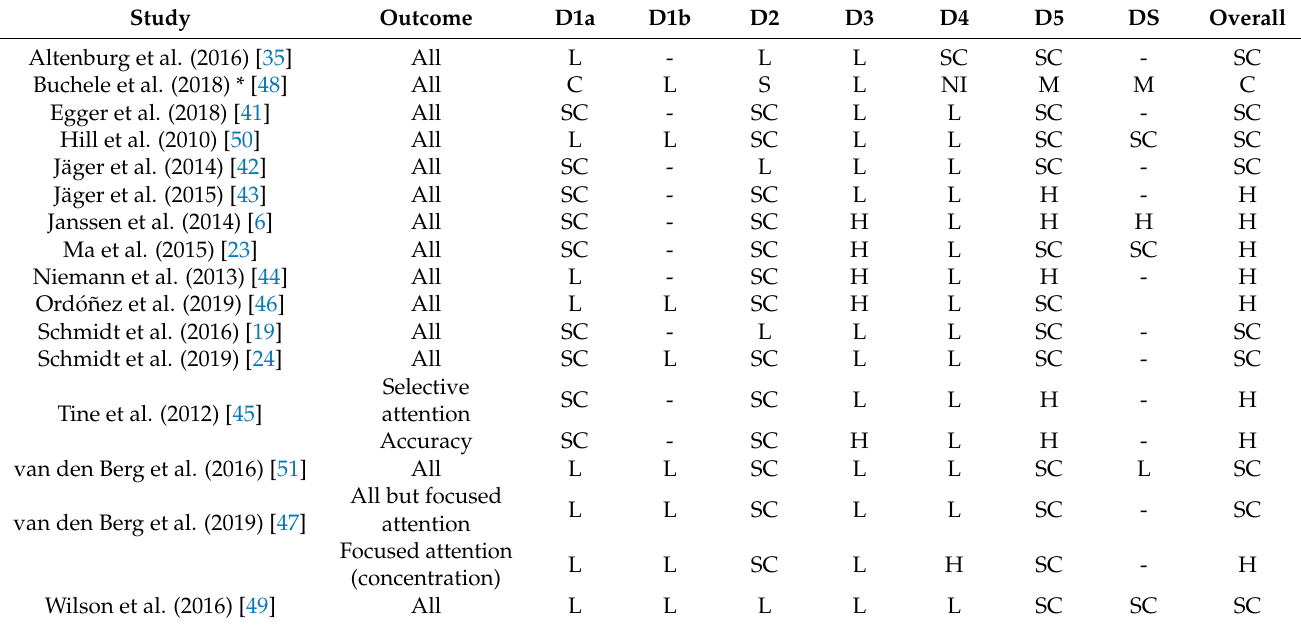
Table A2. Qualitative assessment.